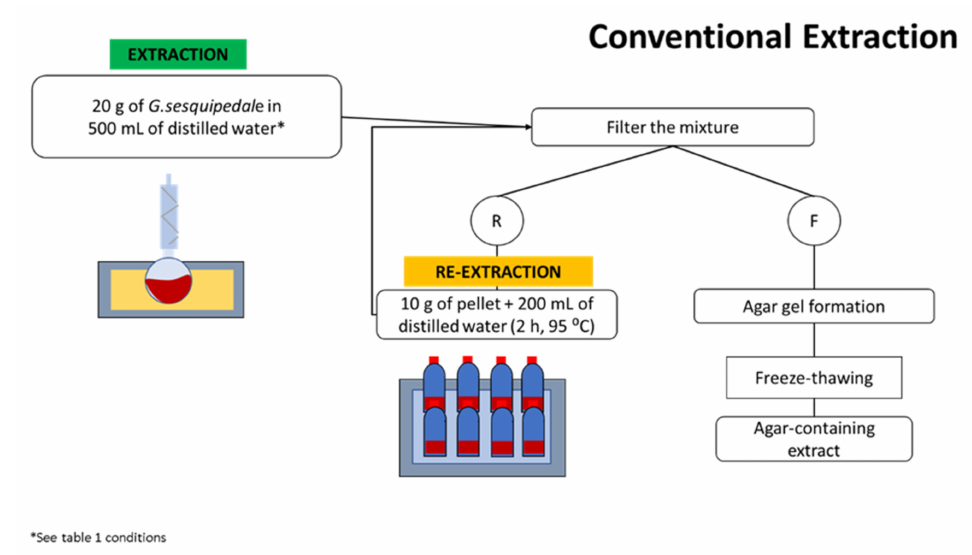
Figure 1. Workflow of the conventional extraction method performed for agar extraction (R: seaweed residue; and F: filtrate).